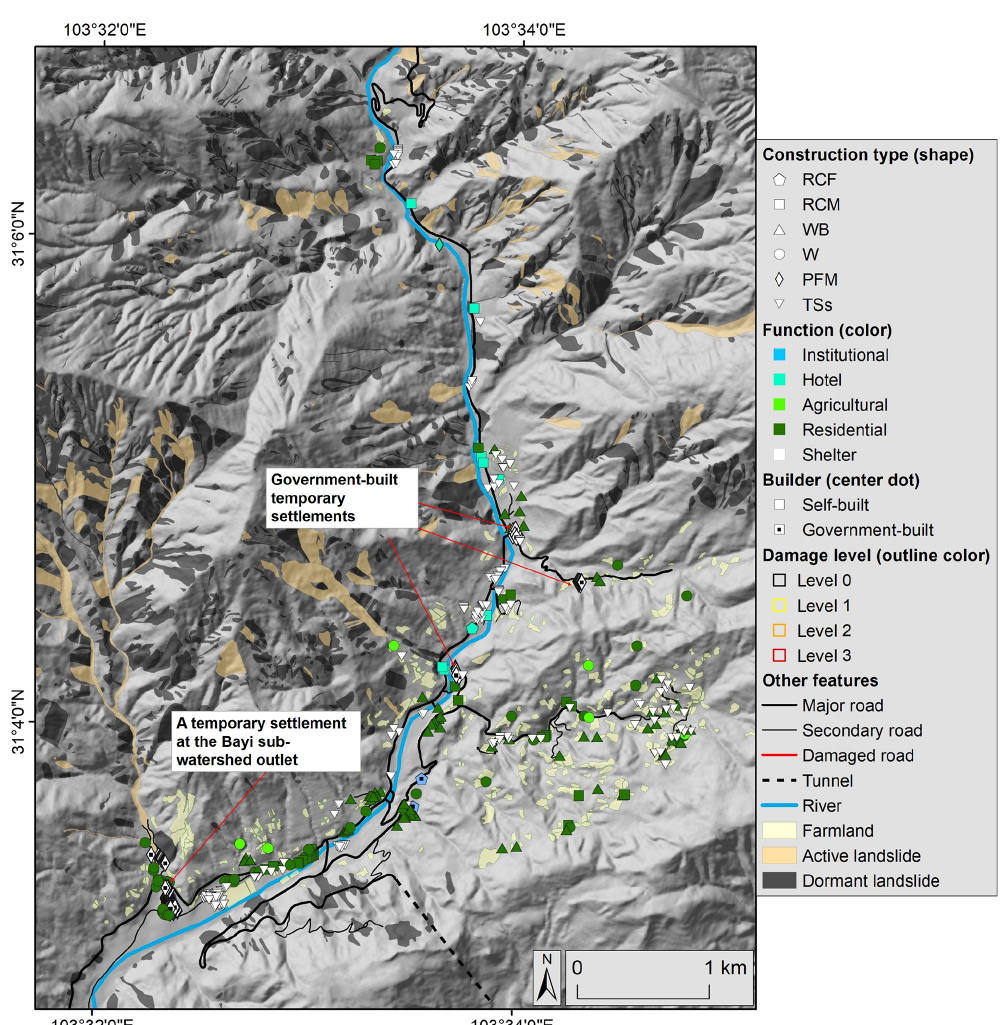
Figure 5. Map of the buildings that survived the earthquake and location of temporary shelters. Many local residents set TSs near their destroyed houses. The government established four PFM temporary settlements, and one of them was located at the outlet of the Bayi catchment, which posed a great debris flow threat due to 29% of the area being covered by